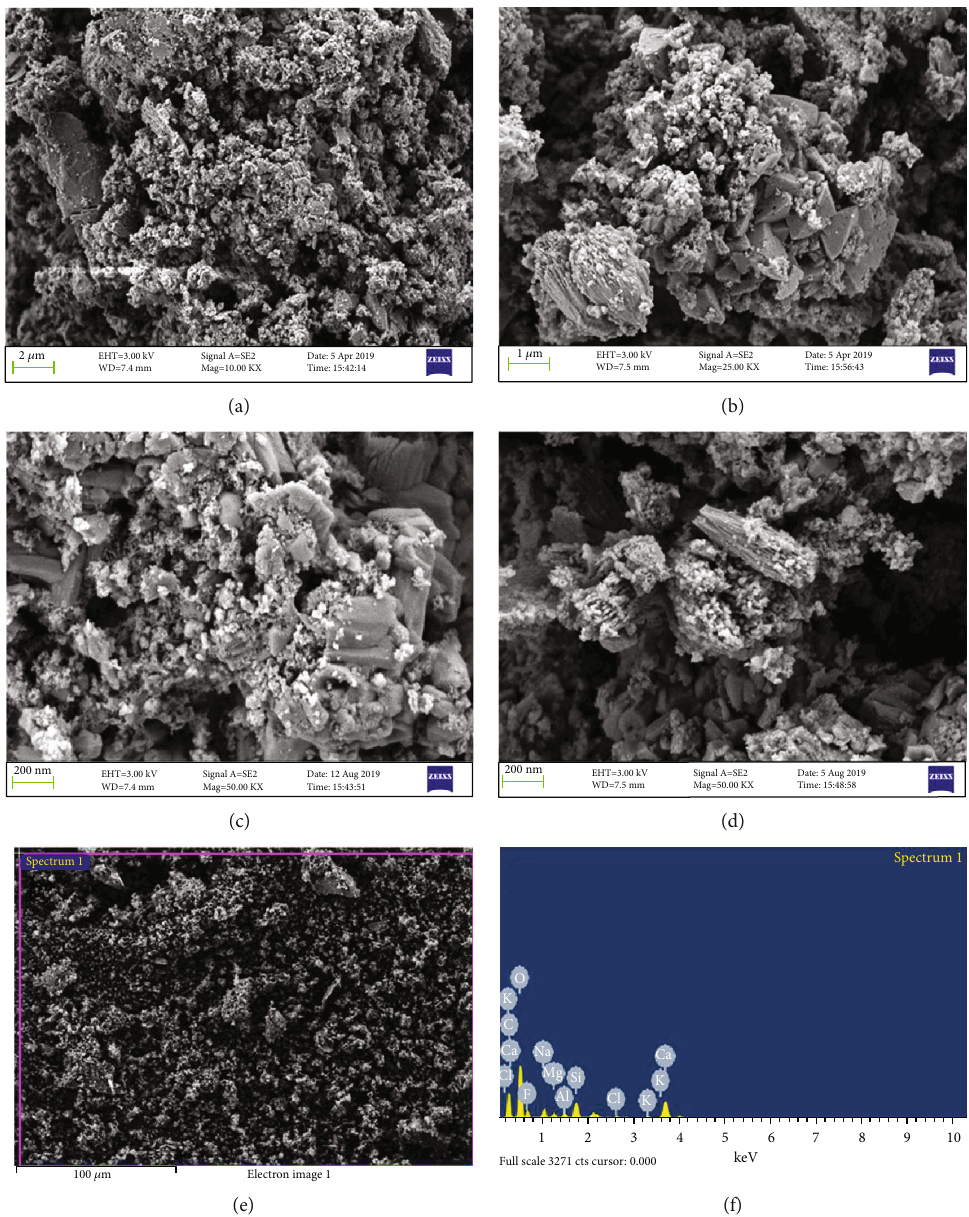
Figure 5: FESEM micrographs of the sintered product (a – d), EDS spot (e), and EDS